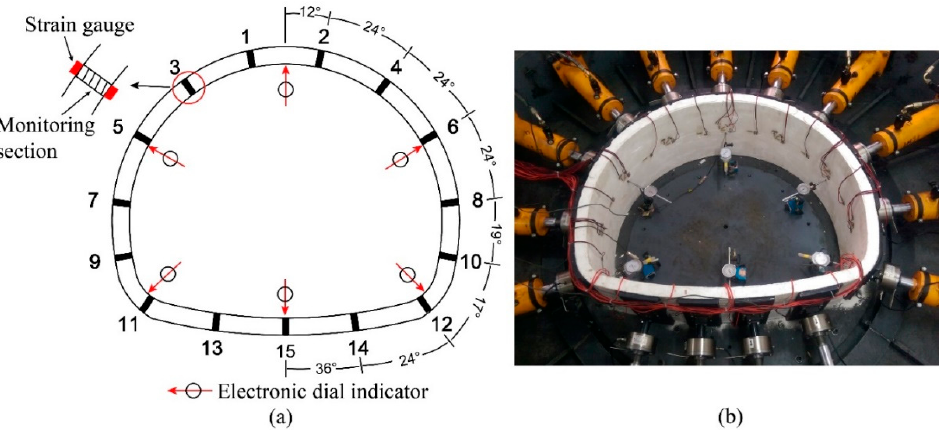
Figure 13. Internal force and deformation monitoring location: ( a ) The monitoring position of the internal force and deformation; ( b ) The monitoring element layout.